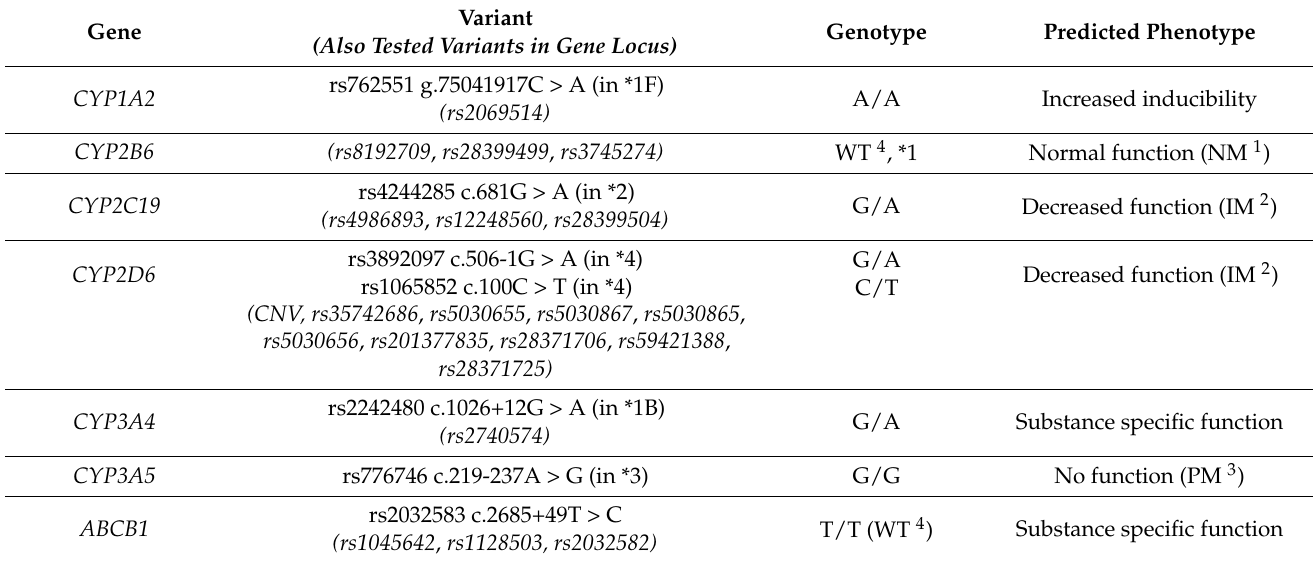
Table 2. Case #1 selected results of the panel-pharmacogenotyping and phenotype interpretation. Gene